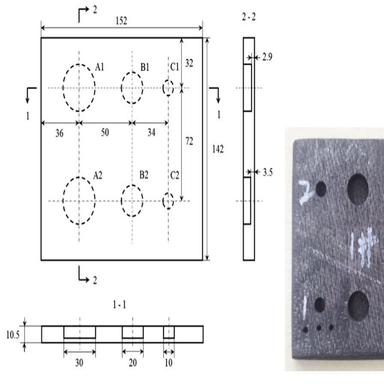
Sample B.